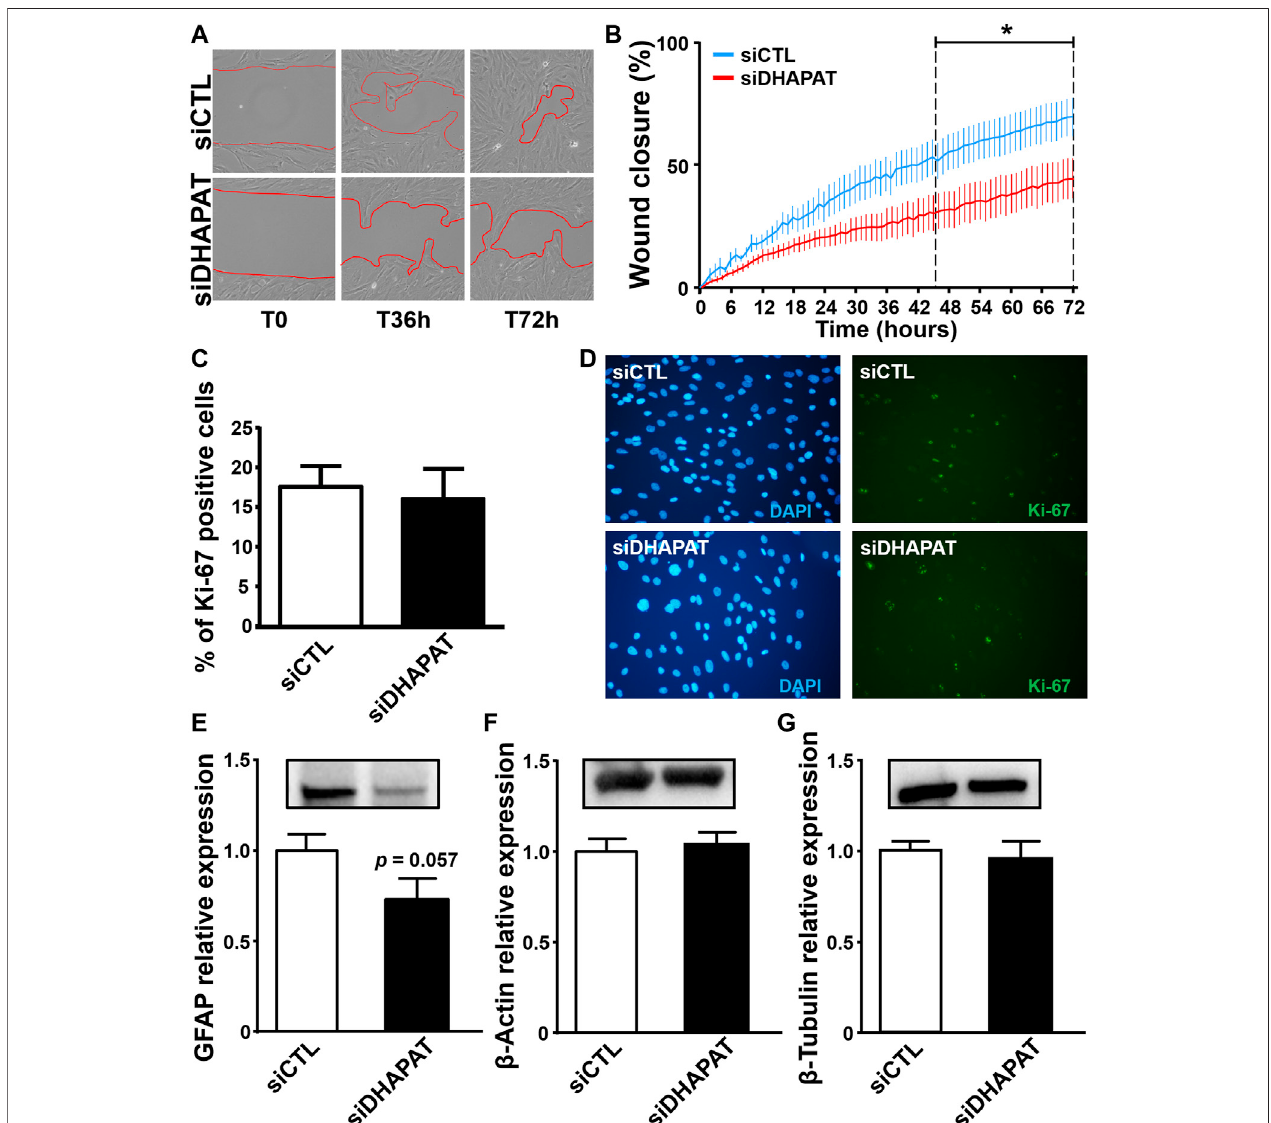
FIGURE 9 | Plasmalogen depletion of primary Müller cells is associated with a decrease of cell migration as well as GFAP expression, but does not modify cell proliferationorothercytoskeleton-relatedproteinsexpression. (A) RepresentativemicrographsofprimaryMüllercellstreatedwithacontrolsiRNA(siCTL)oraDHAPAT- targetingsiRNA(siDHAPAT)inawoundclosureassaybeforetreatment(T0),36and72 haftertreatment. (B) Quanti fi cationofwoundclosureassays.Summarygraphof Müller cells migration speed represented as a percentage of wound closure at indicated time points. Plasmalogen-depleted Müller cells exhibited a signi fi cant reductionofmigration speedwhencomparedtocontrols (siDHAPATvs. siCTL, p < 0.05) ( n =10forsiCTL, n = 9forsiDHAPAT).Two-way ANOVAwithTukey ’ smultiple comparisons test. (C) Müller cells proliferation. Ki-67-labeled Müller cells were quanti fi ed as a percentage (%) of DAPI-positive cells. Plasmalogen-depleted Müller cells didnotshowanyalterationofproliferationwhencomparedtocontrols(siDHAPATvs.siCTL)( n =10forsiCTL, n =9forsiDHAPAT). (D) Fluorescencemicrophotographs of DAPI and Ki-67-labeled Müller cells in siCTL and siDHAPAT-transfected groups. (E – G) Western-blot analyses show a reduction of GFAP expression in